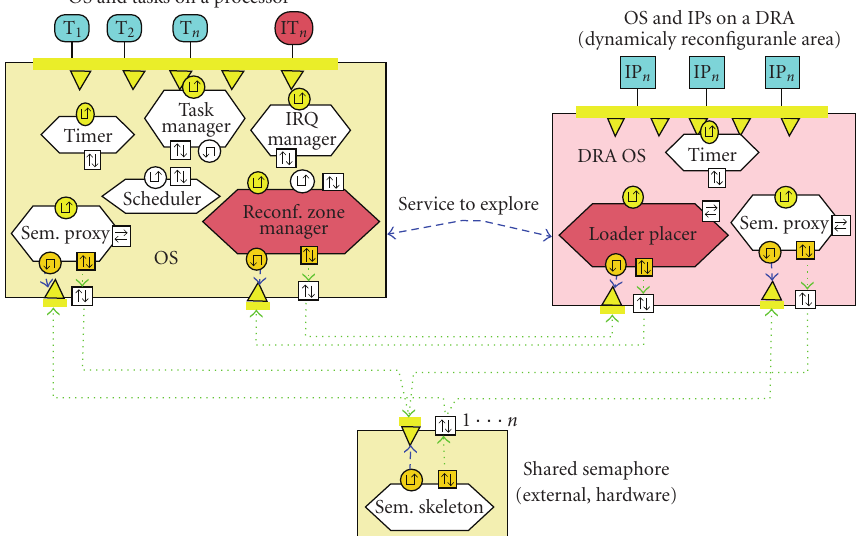
Figure 9: Model of RSoC specific OS: one standard customized with a DRA manager, one specific into the DRA, and another one specific for a refined shared semaphore service alone as an external